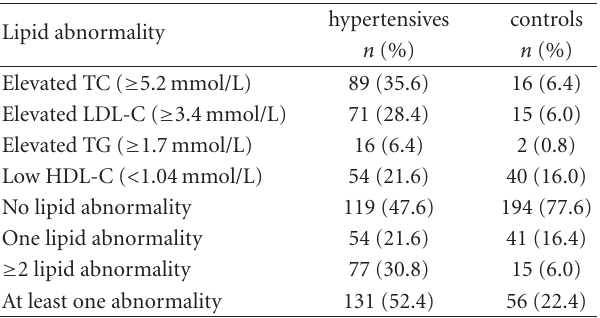
Table 2: Prevalence of various serum lipid abnormalities among the study